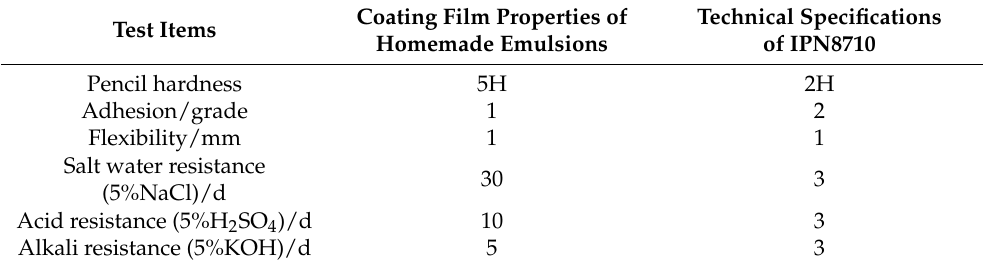
Table 11. Comparison of coating film performance of two